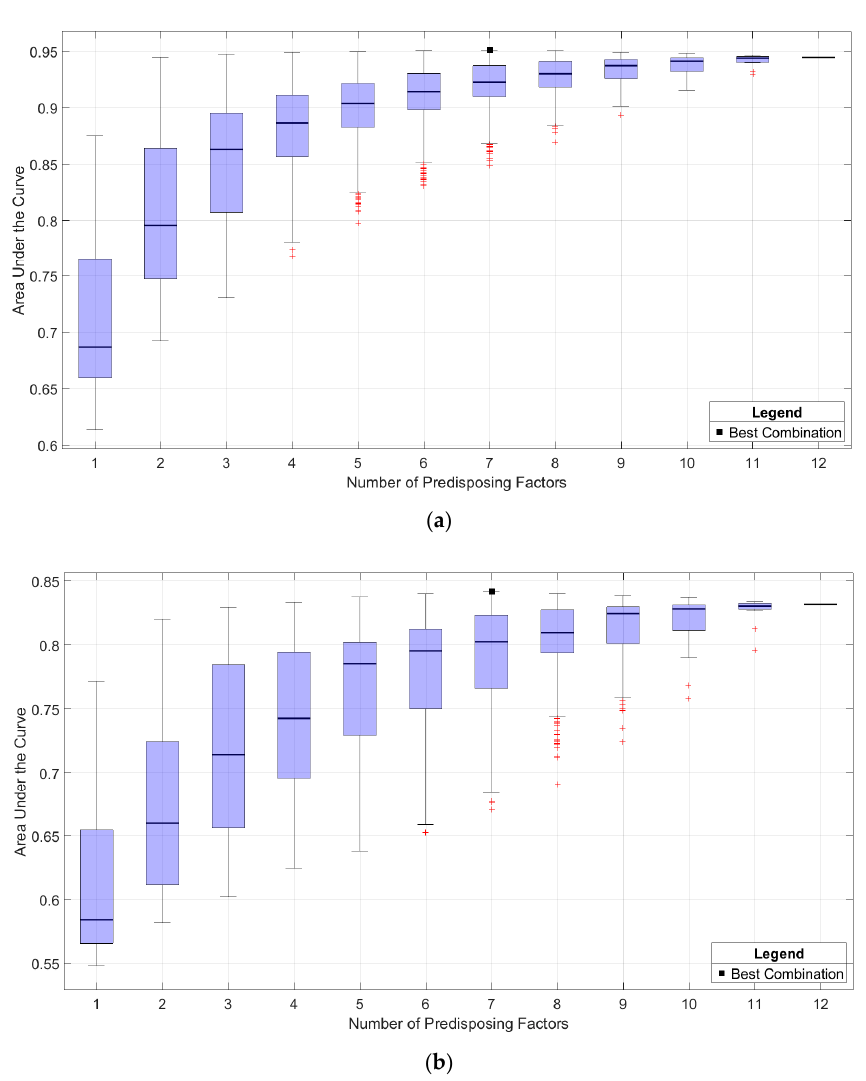
Figure 7. Susceptibility models’ goodness of fit versus the number of predisposing factors used for modeling for: ( a ) falls and ( b ) slides.